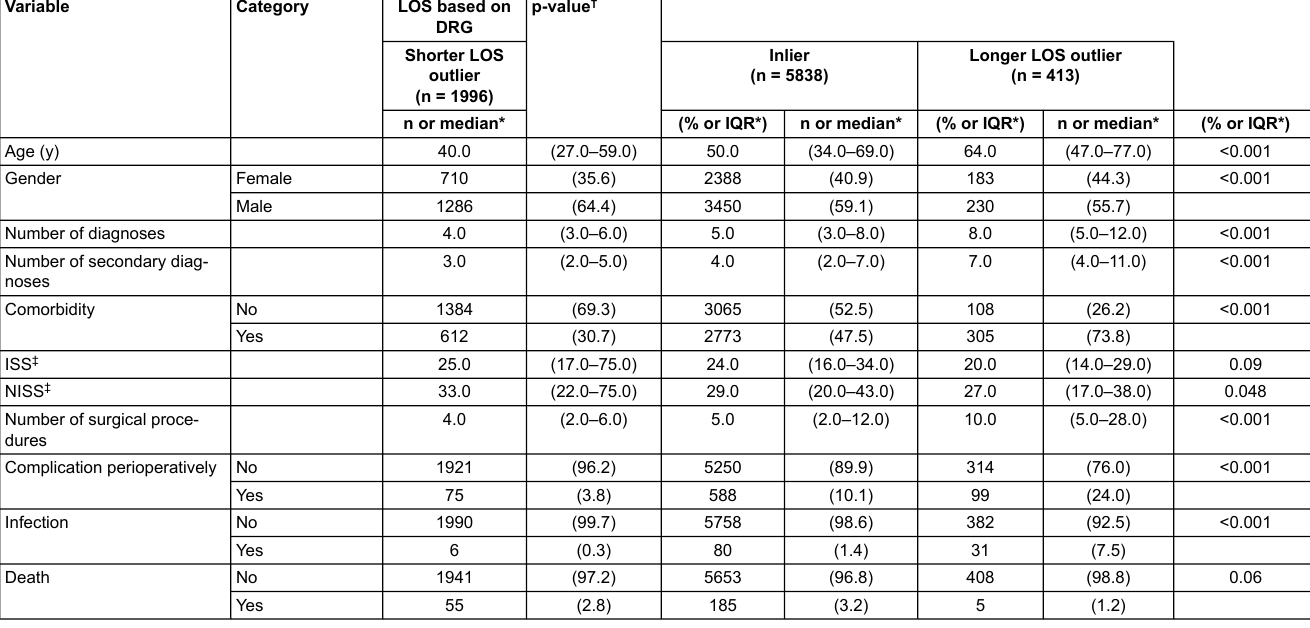
Table 1: General patient characteristics according to the length of hospital stay (LOS), based on diagnosis related group (DRG) (n = 8247).